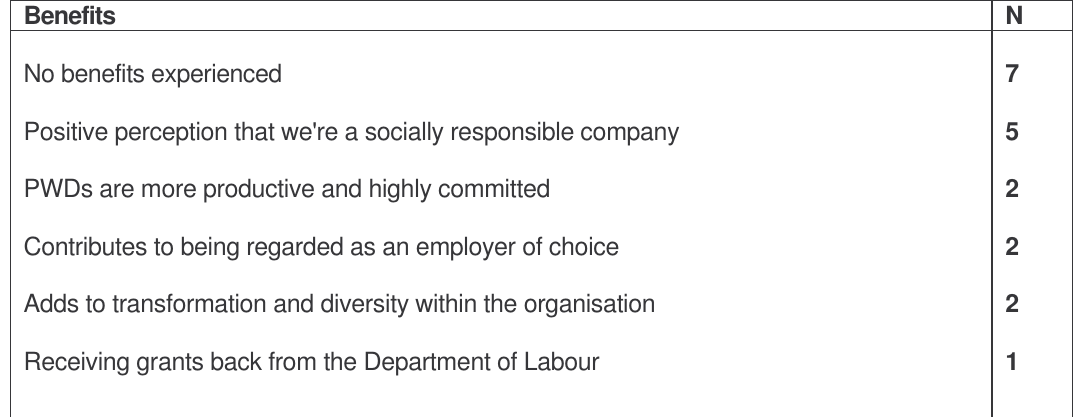
Table 11: Benefits accrued from the employment of people with disabilities Benefits